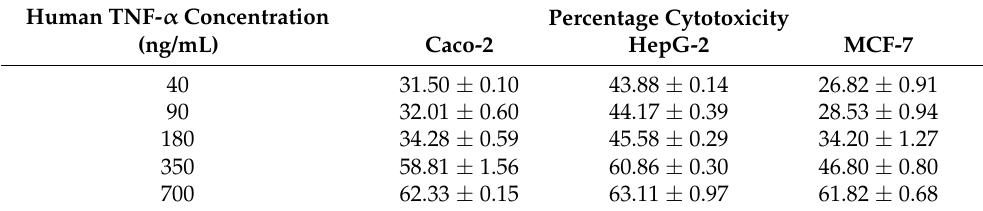
Table 11. Cytotoxicity of cell-free synthesized human TNF- α on human cancer cell lines.